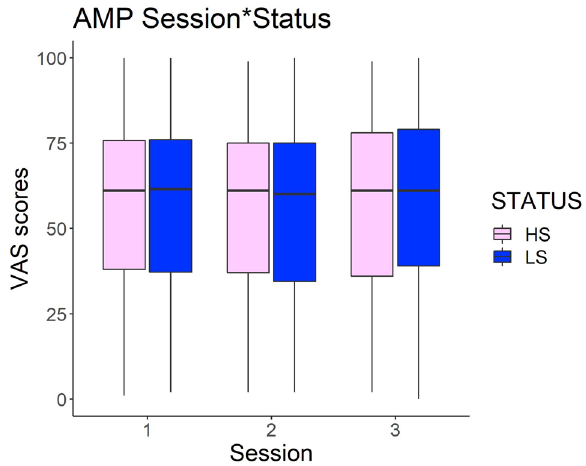
Figure 4. Vas scores attributed to the neutral primes preceded by the high status (HS) and the low status (LS) confederates’ picture in Session 1 (before the status manipulation), Session 2 (after the status manipulation) and Session 3 (after the Joint Grasping task). Horizontal lines in the boxes indicate the median, upper and lower borders indicate 1st and 3rd quartile, "whiskers" extend to the farthest points that are not outliers.